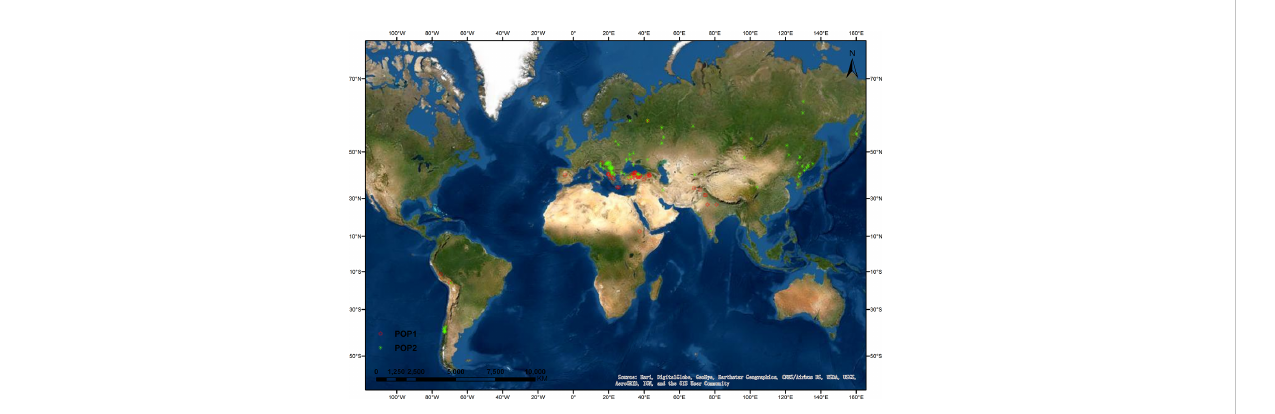
FIGURE 2 Geographical distribution of oat landraces at K = 2. The locations of oat landraces, with population membership coef fi cient ≥ 0.7, are indicated by different